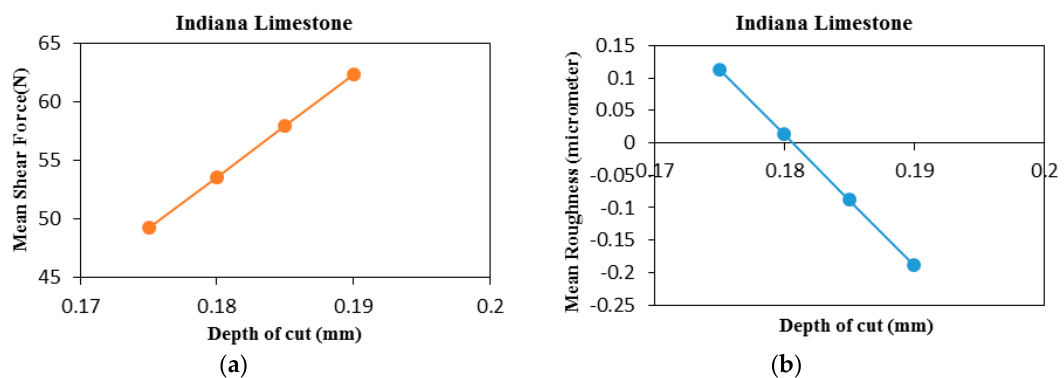
Figure 17. Evolution of the tangential load and the groove asperity at various DOCs: ( a ) d = 0.18 mm; ( b ) d = 0.19 mm.